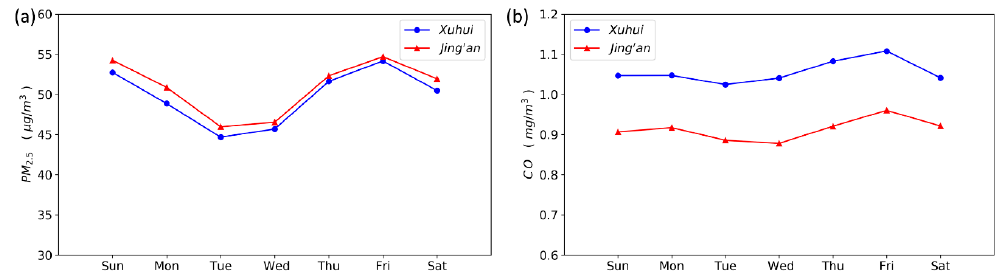
Figure 7. Weekly variation of the average PM 2.5 concentration in the two monitoring stations. ( a ) PM 2.5 ( b ) CO.